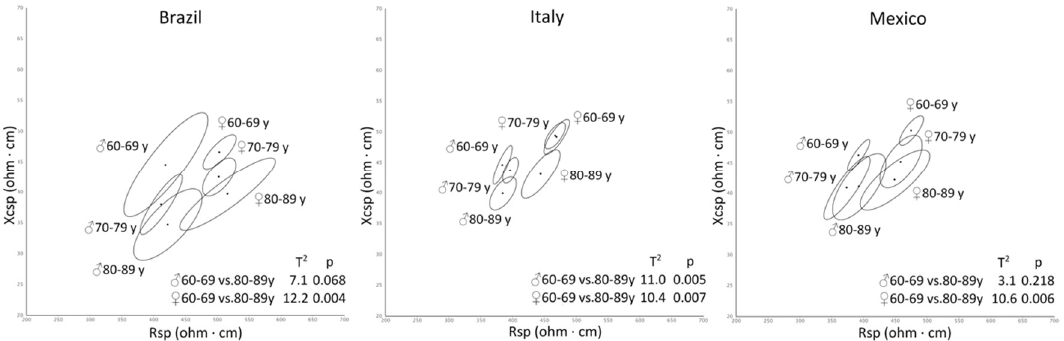
Figure 1. Confidence ellipses for age, sex, and population groups.